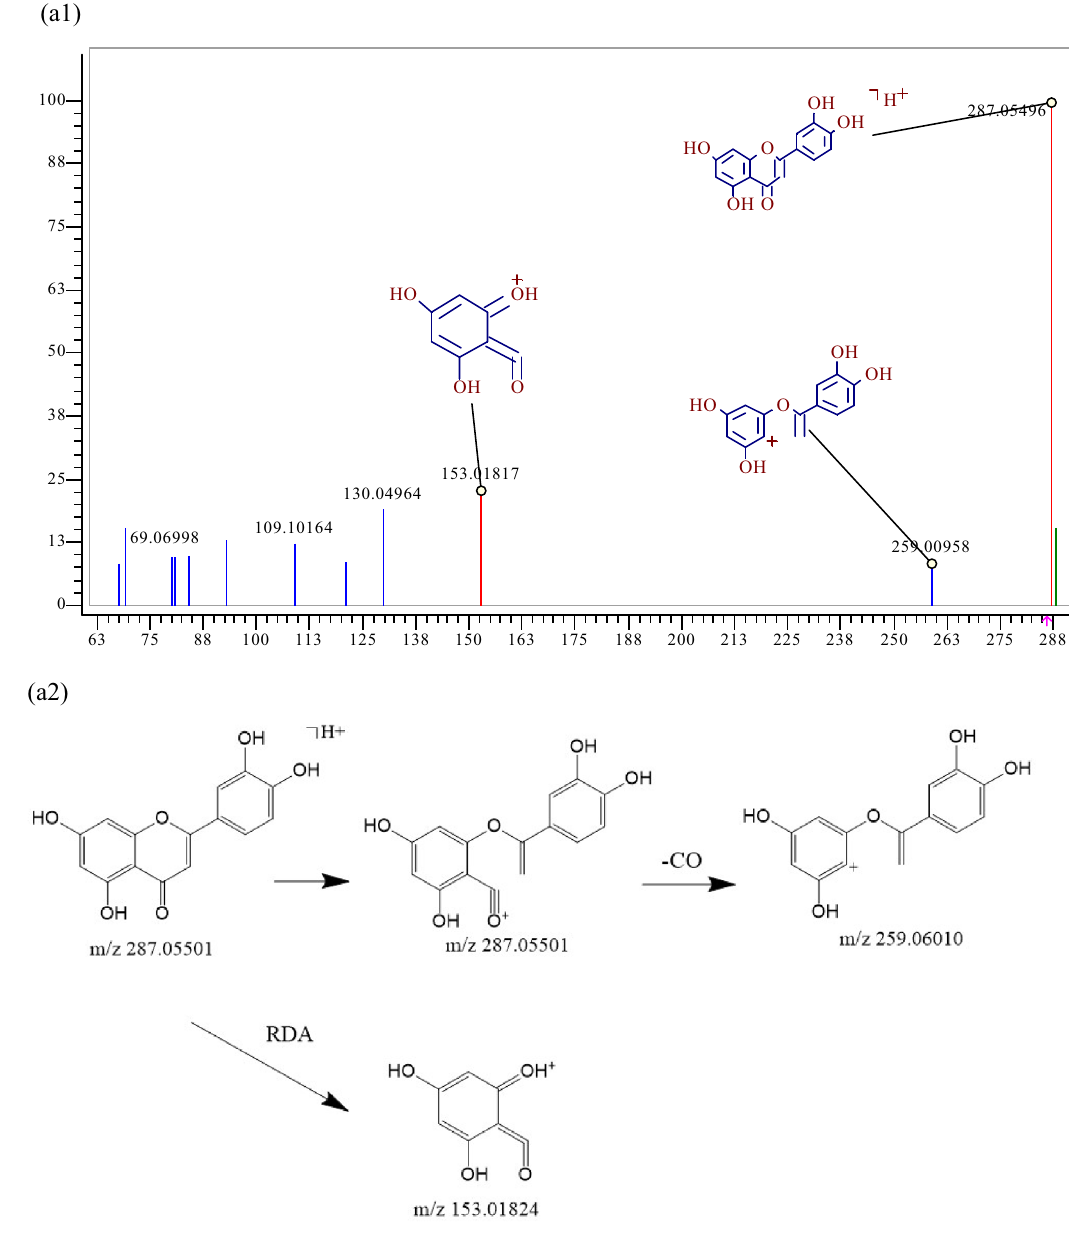
Figure 3. MS 2 spectra and cracking diagram of ( a ) luteolin ( b ) baohuoside